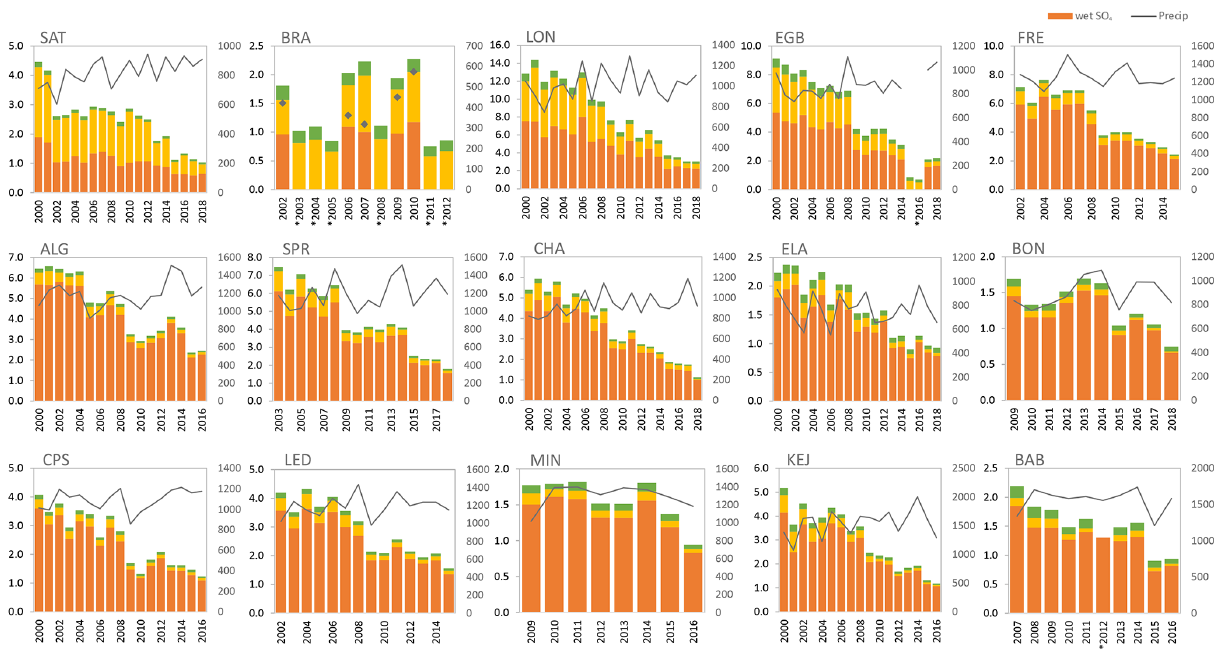
Figure 10. Long-term annual trends in total (dry + wet) deposition of sulfur at CAPMoN sites, 2000–2018. Total deposition (kgSha − 1 yr − 1 , primary y axis); precipitation (mmyr − 1 , secondary y axis); ∗ indicates dry or wet deposition data were not available because data complete- ness criteria was not